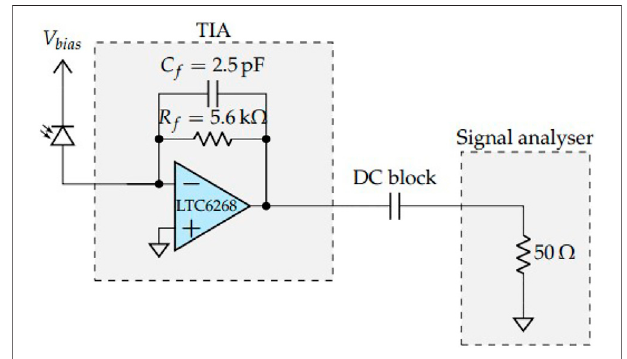
Frontiers in Physics |